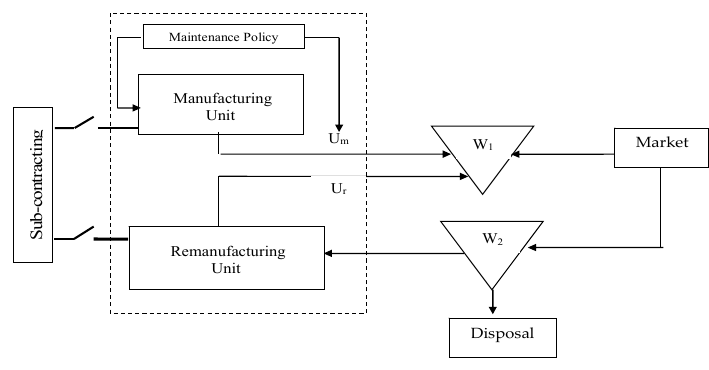
Figure 1. Closed-loop Production System.